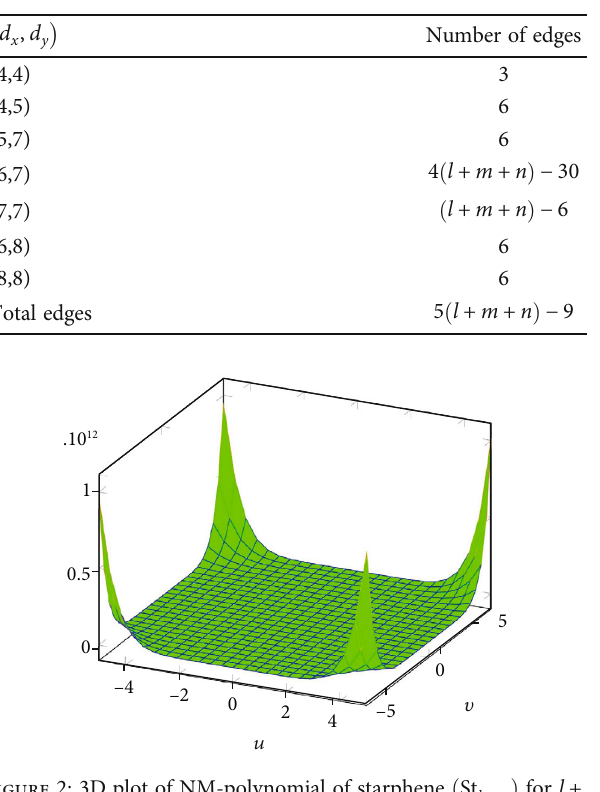
Table 2: Edge partition of starphene St